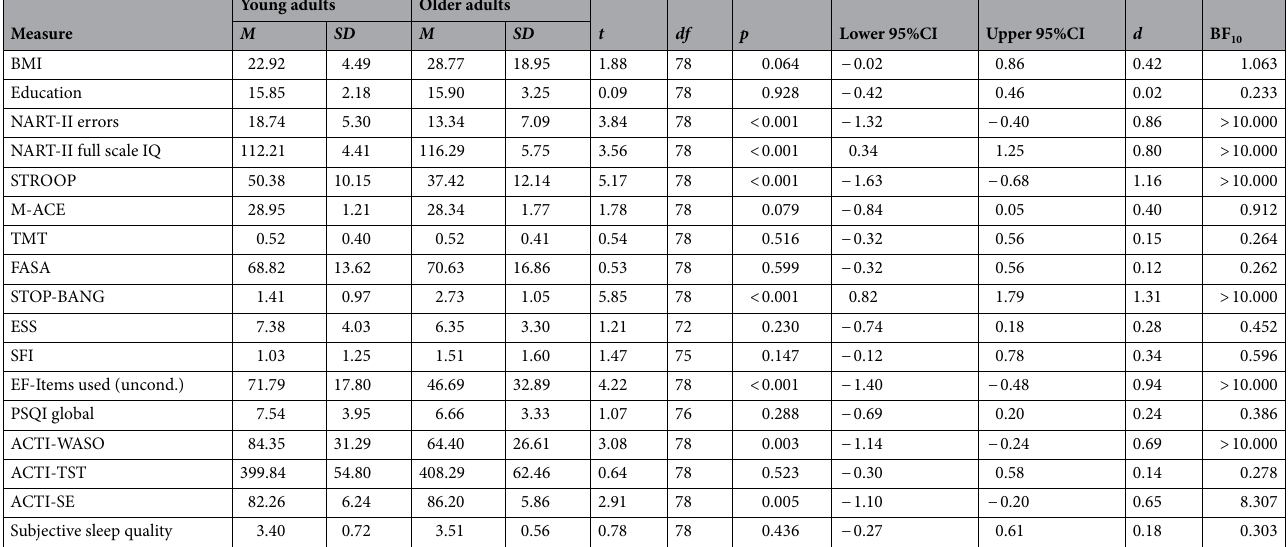
Table 1. Means, standard deviations, independent samples t -tests, and Bayesian t -tests across younger and older adults for background measures. d Cohen’s d measure of effect size, Lower/Upper 95%CI lower and